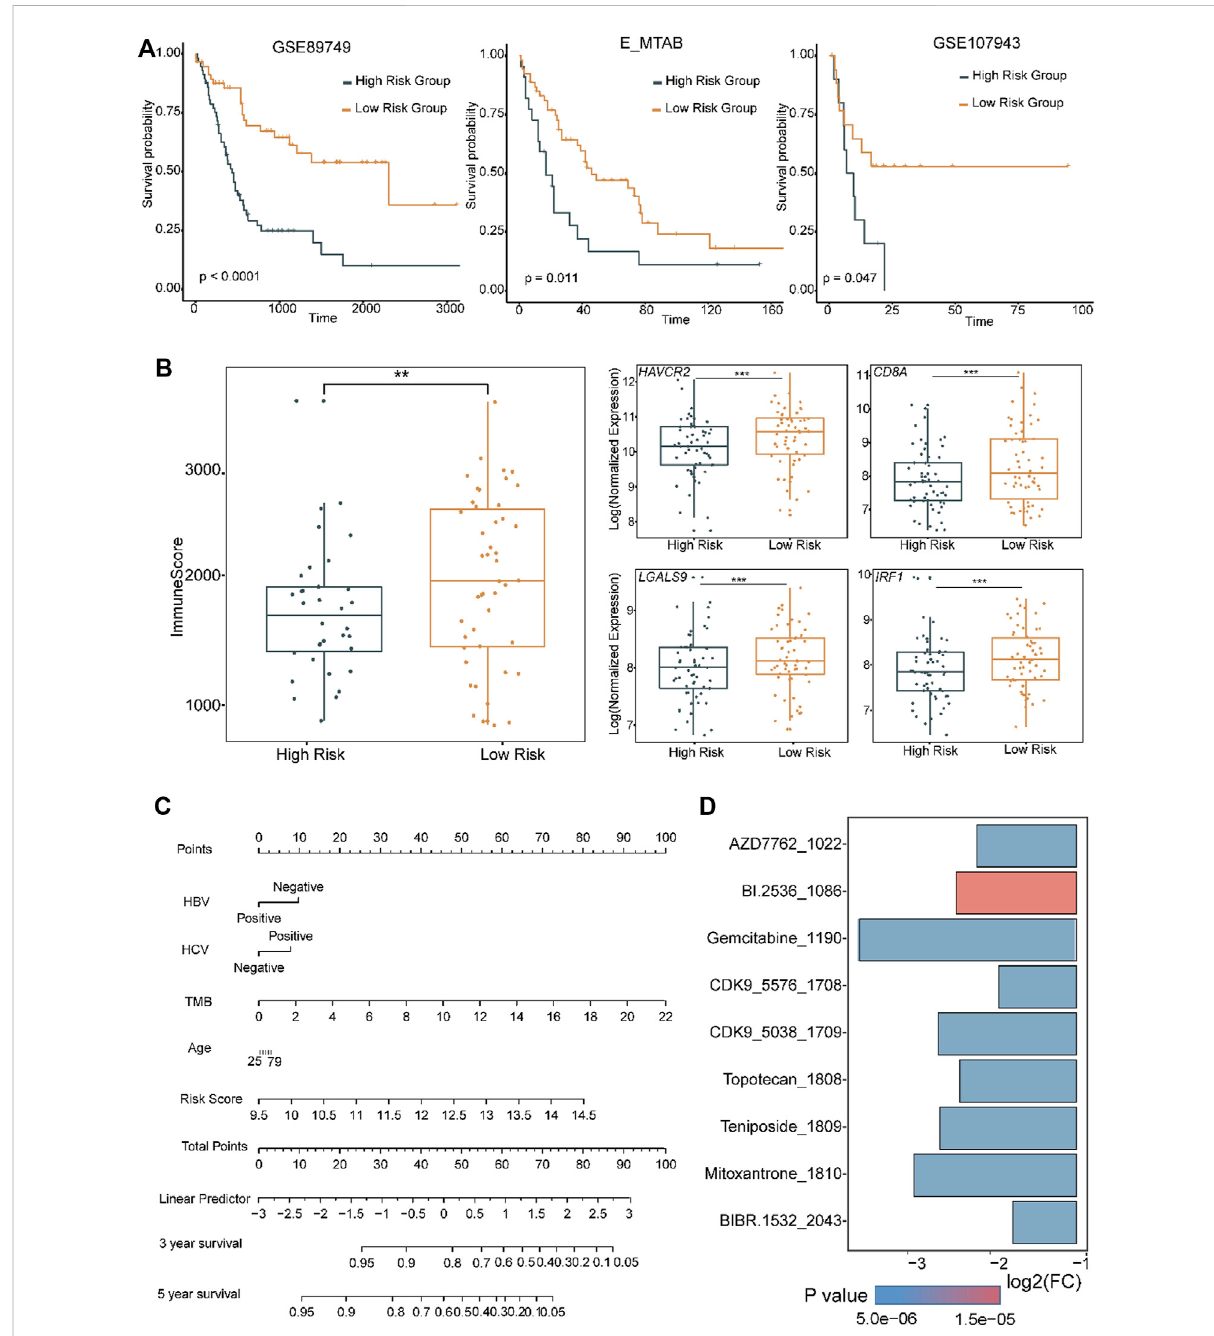
FIGURE 6 Distinct functions in different level of tumor microenvironment risk scores. (A) Overall survival curves showing the prognosis results with different level of tumor microenvironment risk score (TMRS) in the two CCA cohorts using the genes obtained from eLBP-LASSO. Statistical signi fi cance was calculated using the log-rank test. (B) Box plots showing the immune and the exhausted related genes in high and low risk group (** p < 0.01; *** p < 0.001; Wilcoxon rank sum test). (C) Nomogram plot showing the predicted 3- and 5-year survival possibilities of individual CCA patients. (D) Bar plot showing the drug sensitivity in S2